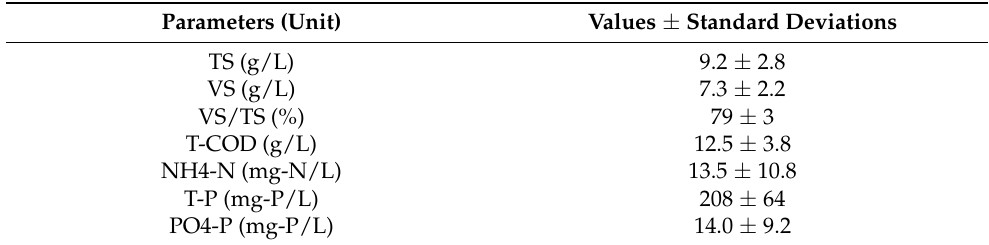
Table 2. Characteristics of the raw WAS ( n =